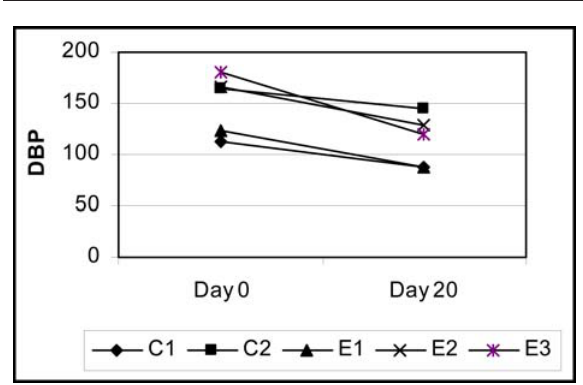
FIGURE 1 - Rats systolic blood pressure (SBP) profile during pregnancy. SBP values decreased significantly in Day 20 compared with Day 0 in all groups (p<0.001) Levels were similar in treated and untreated rats.